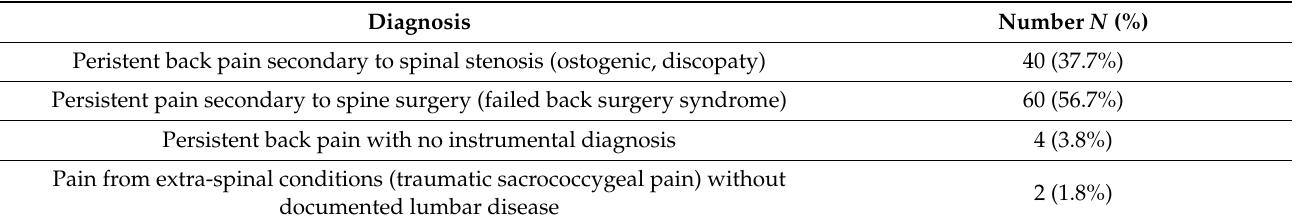
Table 1. Description of types of chronic persistent lumbar pain with or without radicular pain.